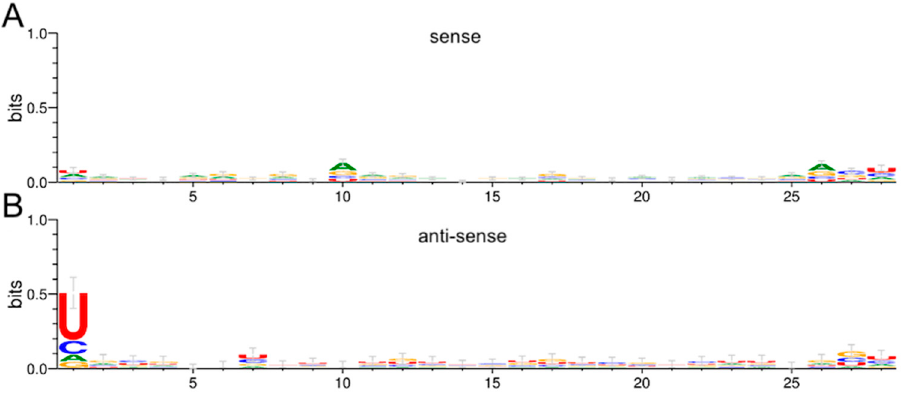
Figure 12. RRV vpiRNA signatures in Ae. aegypti . ( A ) There was an A 10 nucleotide bias, indicative of ping ‐ pong amplification, present in the 28 nt sense vpiRNA ‐ like strands produced in Ae. aegypti fat body tissue at 6 dpi with RRV, although there were other biases at positions 1 and 26–28. ( B ) The U 1 bias, a signature of piRNA ping ‐ pong amplification, was evident in 28 nt piRNAs produced in Ae. aegypti fat body at 6 dpi.